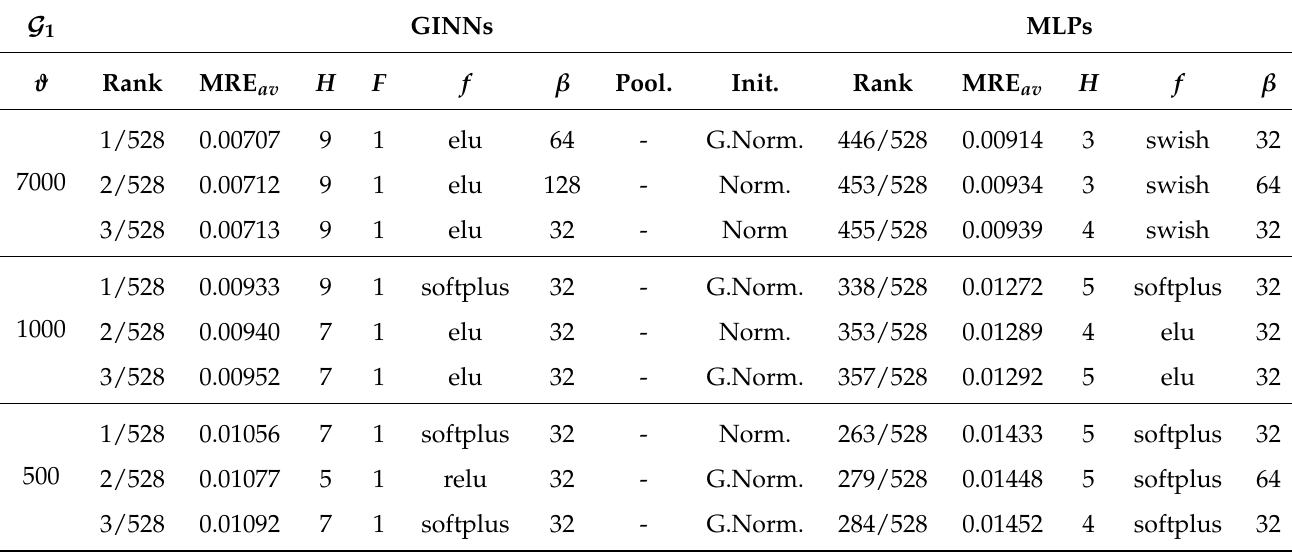
Table 1. Network . Top three GINNs and MLPs, for ϑ = 7000,1000,500. Models are sorted with G 1 respect to the MRE av error; the “rank” column describes their global position with respect to all the other models.